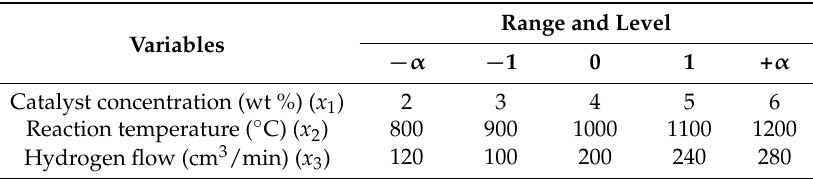
Table 1. Experimental ranges and levels of the independent